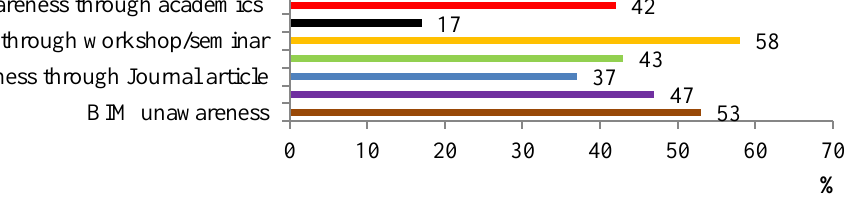
Fig. 7. The level of awareness of BIM for PB management (developed by the authors).